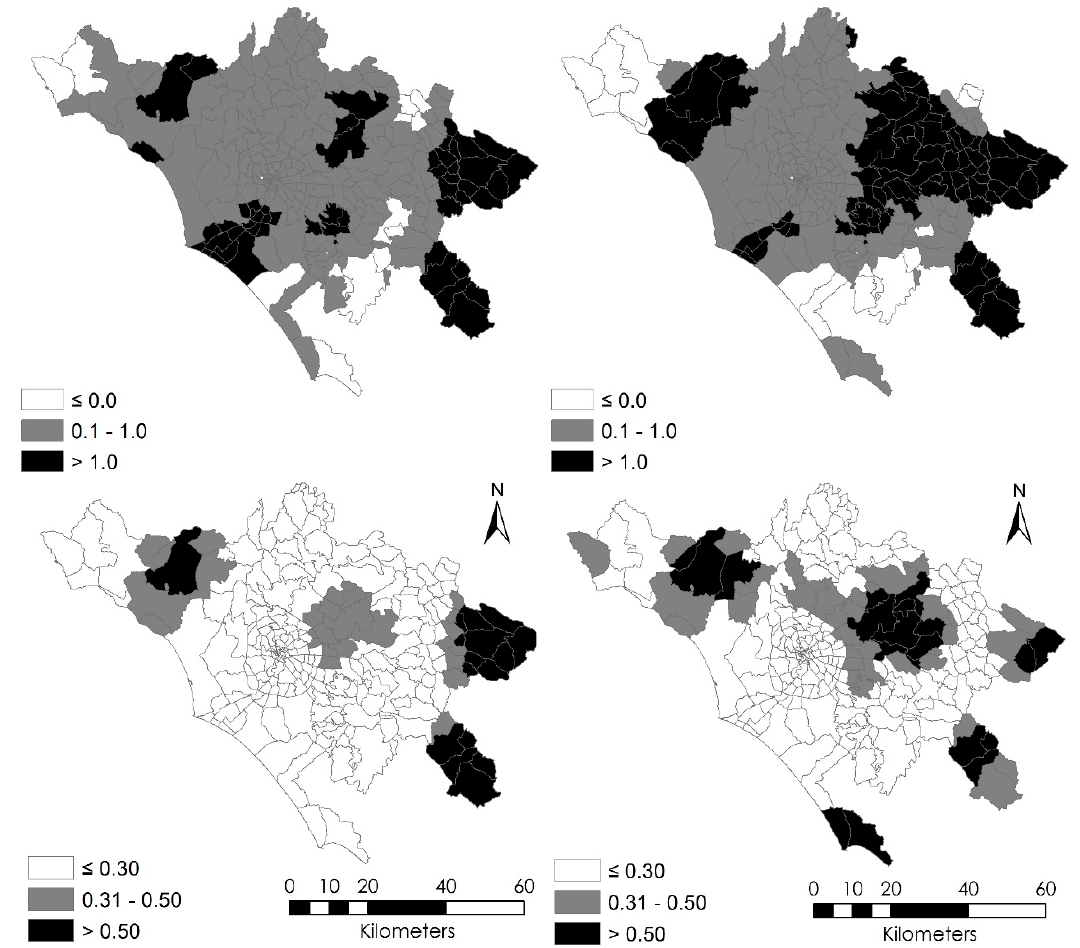
Figure 6. Results of a Geographically Weighted Regression assessing the relationship between the percent share of forest cover in total landscape and the distance from downtown Rome by year ( left : 1936; right : 2018; upper panel: local slope (regression) coefficients; lower panel: local R 2 goodness-of-fit coefficients).